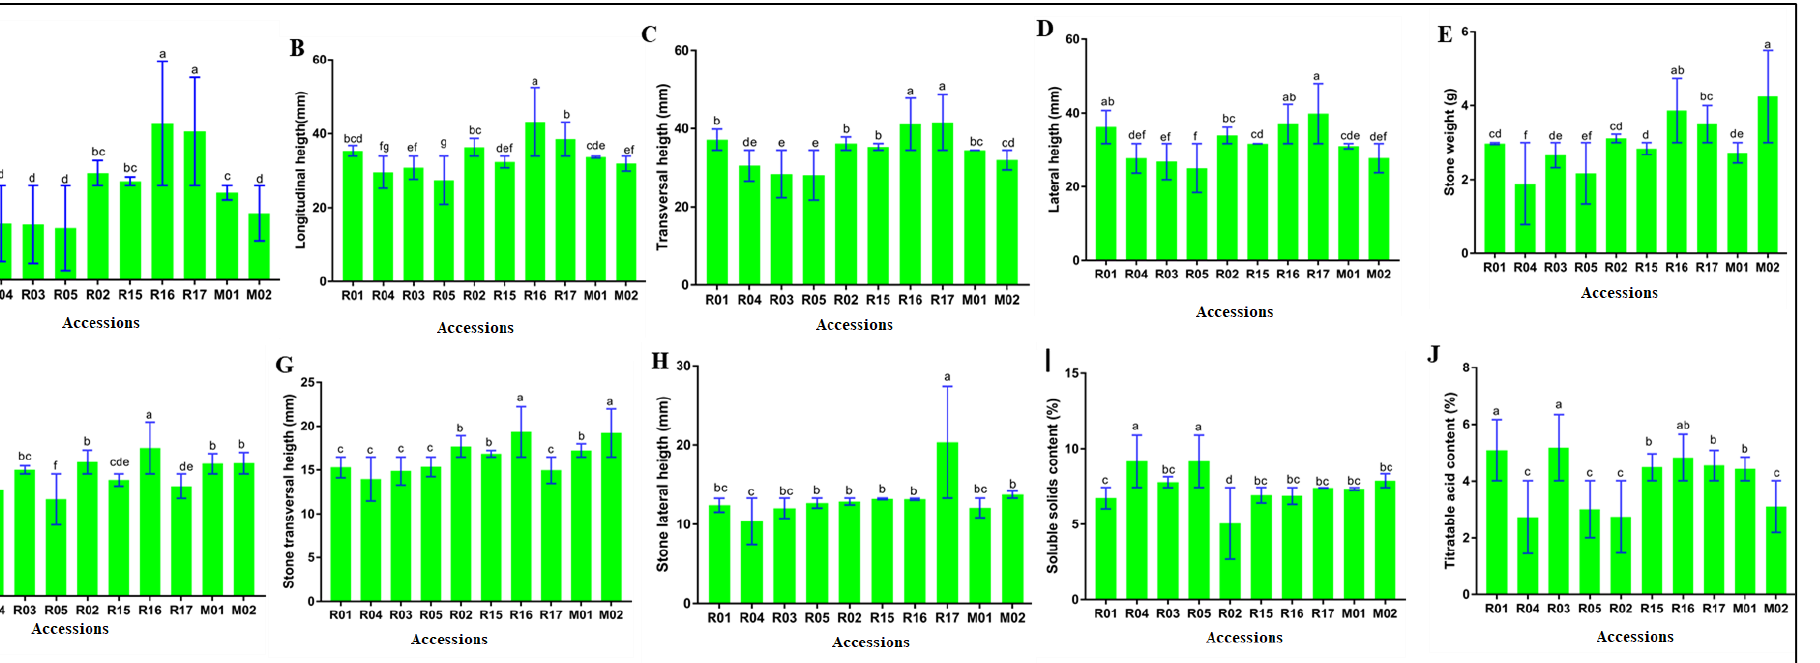
Figure 2. Fruit quality parameters among the 10 accessions of Japanese apricot ( Prunus mume ): R05, M02, R01, R03, R16, R15, R1, R02, M01 and R04: ( A ) fruit weight; ( B ) longitudinal height; ( C ) transversal height; ( D ) lateral height; ( E ) stone weight; ( F ) stone longitudinal height; ( G ) stone transversal height; ( H ) stone lateral height; ( I ) total soluble solids; ( J ) titratable acid content. The bars in each figure represent the mean of three replicates, and error bars represent standard error of means. The bars with a common letter on top indicate no significant difference according to post hoc mean comparison with Duncan’s multiple range test at p < 0.05, whereas those with different letters indicate significant differences at p < 0.05 .